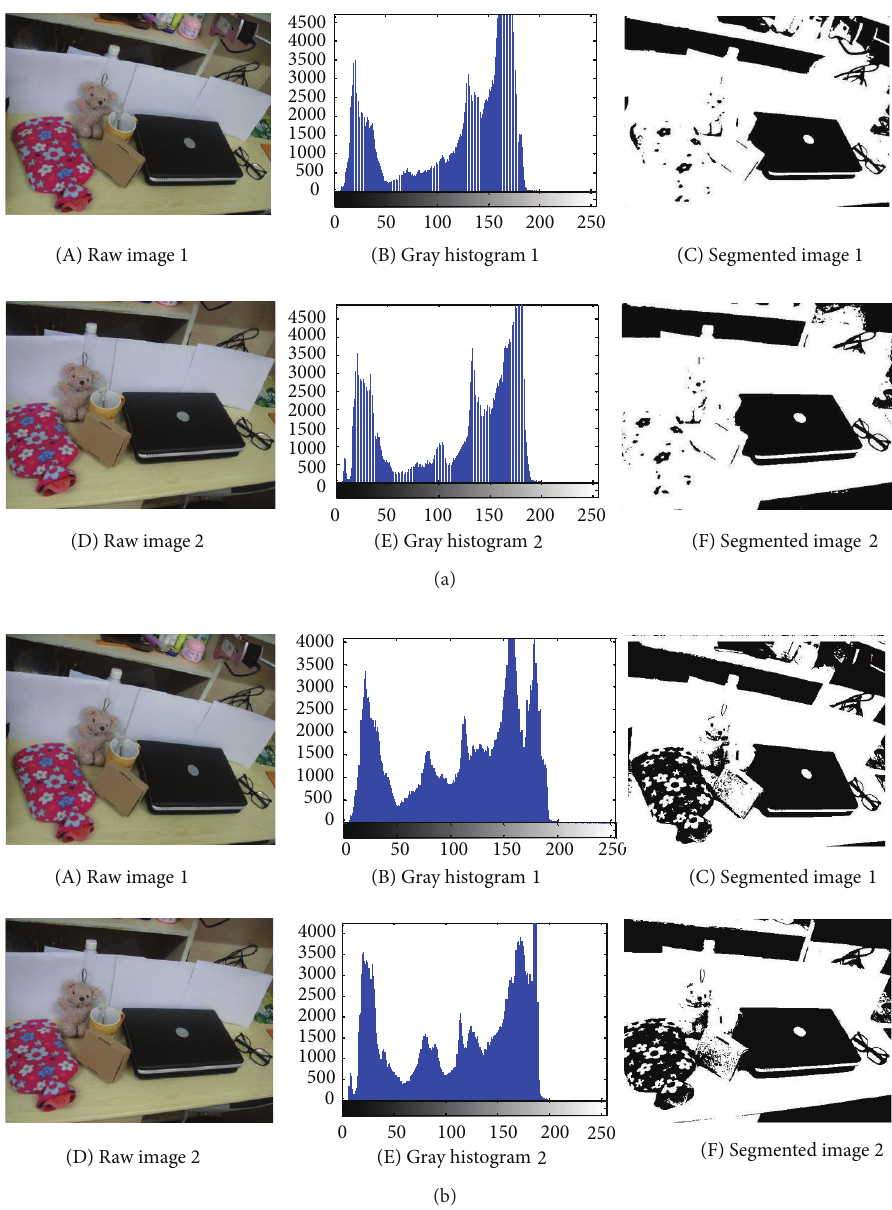
Figure 3: (a) Otsu segmentation on images in group 2. (b) 2DMETS on images in group